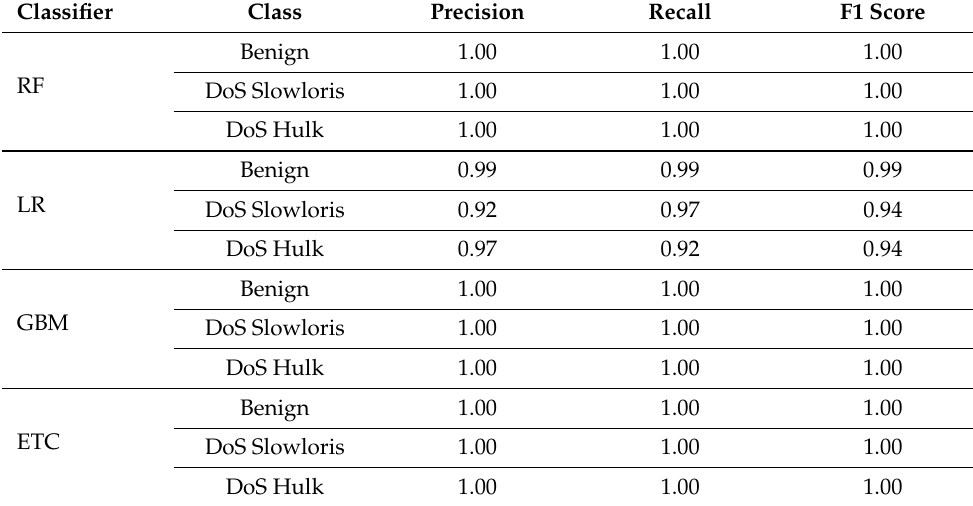
Table 9. Classification report of each learning model with (PCA + SVD).